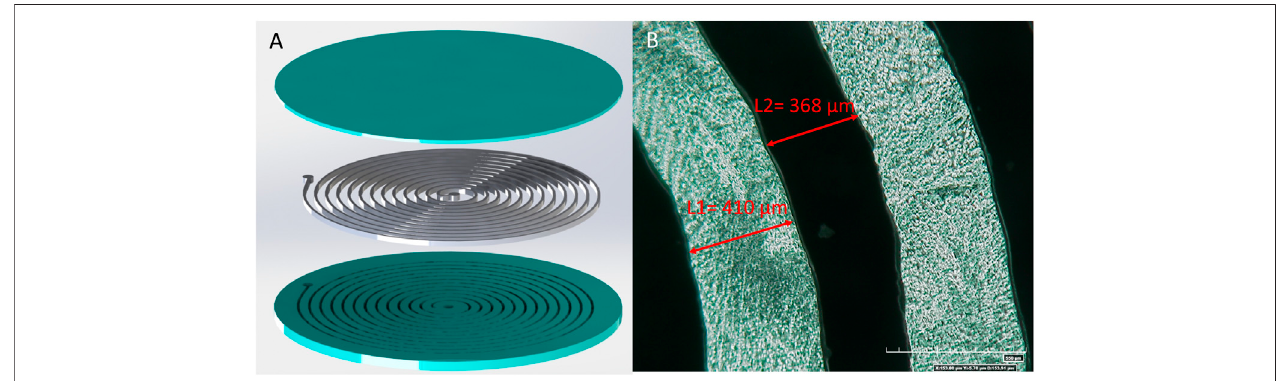
FIGURE 2 | (A) Exploded view of the schematics for composite pads with tunable CoF, PDMS (Blue) LMPA (Silver). (B) Optical image of the fabricated LMPA channels (shiny) in the composite pads (top view) .